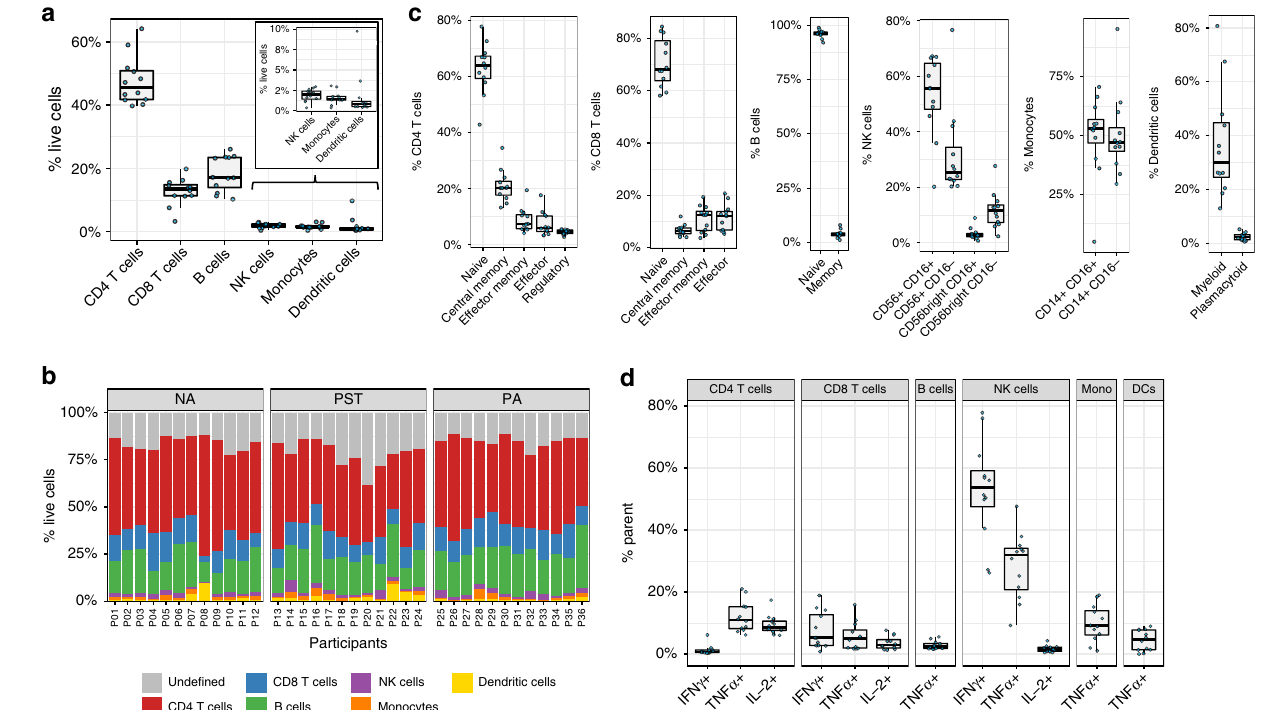
Fig. 2 Immune cell pro fi ling of unstimulated PBMCs from 1-year-old infants by manual gating. a The six major immune cell populations identi fi ed in unstimulated PBMC expressed as percentage of live cells in n = 12 healthy 1-year-old infants. b Stacked bar graph representing the major immune cell populations in each individual, strati fi ed by clinical outcome for non-allergic (NA) ( n = 12), peanut-sensitized tolerant (PST) ( n = 12), and peanut-allergic (PA) ( n = 12) infants. c Each major immune cell population was subtyped into further populations in unstimulated PBMC from n = 12 healthy infants. d Percentage of CD4 T cells, CD8 T cells, B cells, NK cells, monocytes, and dendritic cells (DCs) producing IFN γ , TNF α , or IL-2 following 24 h stimulation of PBMC with PMA/ionomycin in n = 12 healthy infants. In the boxplots, the medians are shown. The “ hinges ” represent the fi rst and third quartile. The whiskers are the smallest and largest values after exclusion of outliers (greater than the 75th percentile plus 1.5 times the IQR or less than 25th percentile minus 1.5 times the IQR). Source data are provided as a Source Data fi